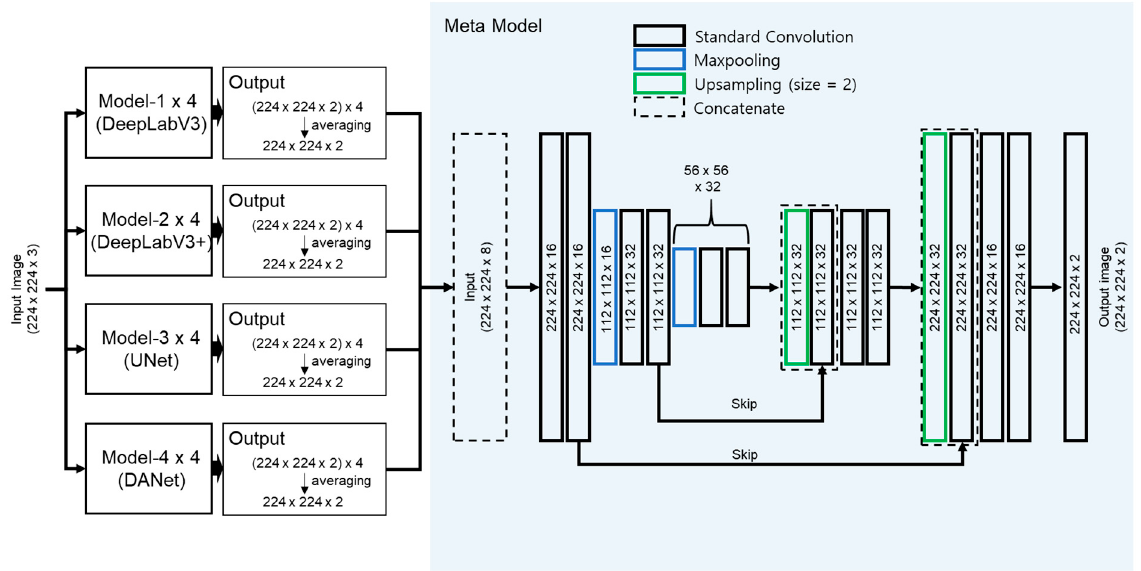
Figure 7. Metamodel architecture.